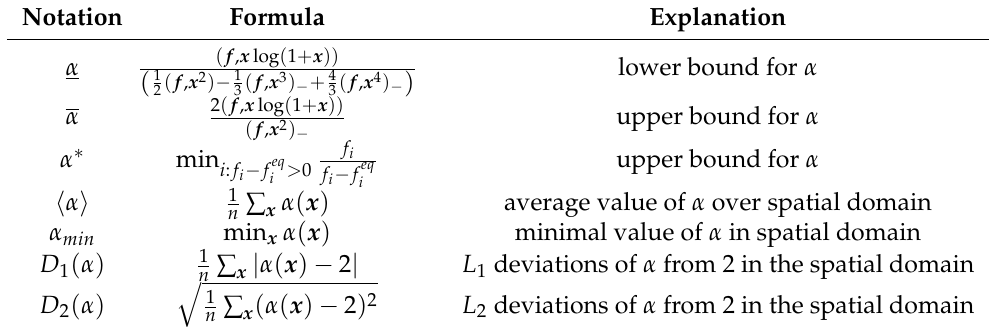
Table A1. List of main